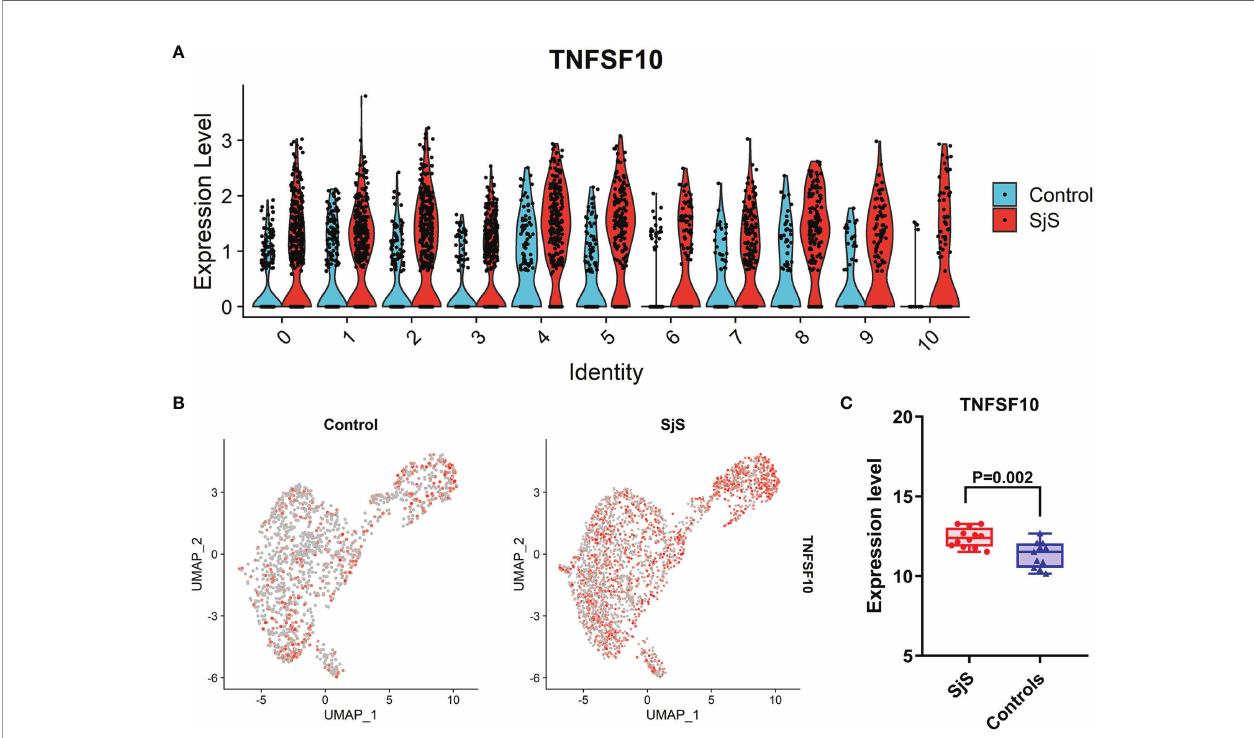
FIGURE 4 | Increased expression of TNFSF10 (TRAIL) in monocytes of SjS patients. (A) , Violin plot shows the increased expression of TNFSF10 (TRAIL) in most monocyte sunsets of SjS patients in the scRNA-seq transcriptome analyses. (B) , Feature plot shows the increased expression of TNFSF10 (TRAIL) in monocytes of SjS patients in the scRNA-seq transcriptome analyses. (C) , Validation study con fi rms the increased expression of TNFSF10 (TRAIL) in monocytes of SjS